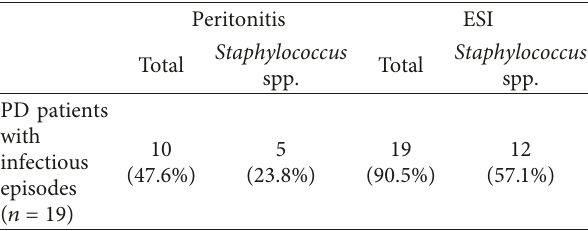
Table 5: Total number of PD patients with one or more infectious episodes, peritonitis, and/or exit-site infections (ESI), in particular caused by Staphylococcus spp.